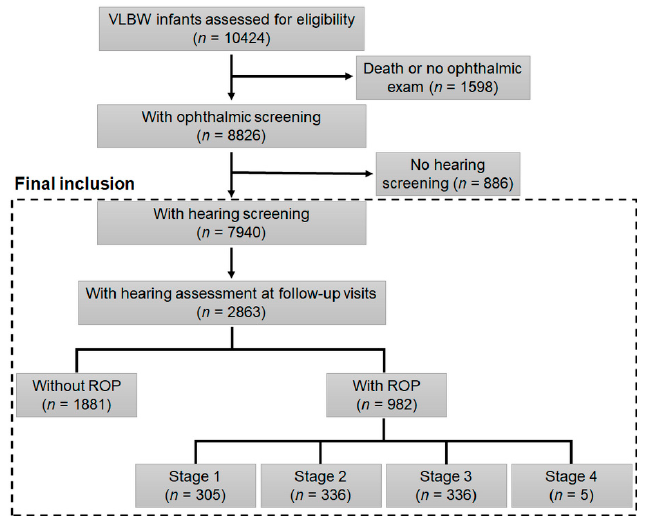
Figure 1. Flowchart illustrating the inclusion and exclusion criteria of the present study and the number of infants meeting the criteria. VLBW = very Low birthweight; ROP = retinopathy of